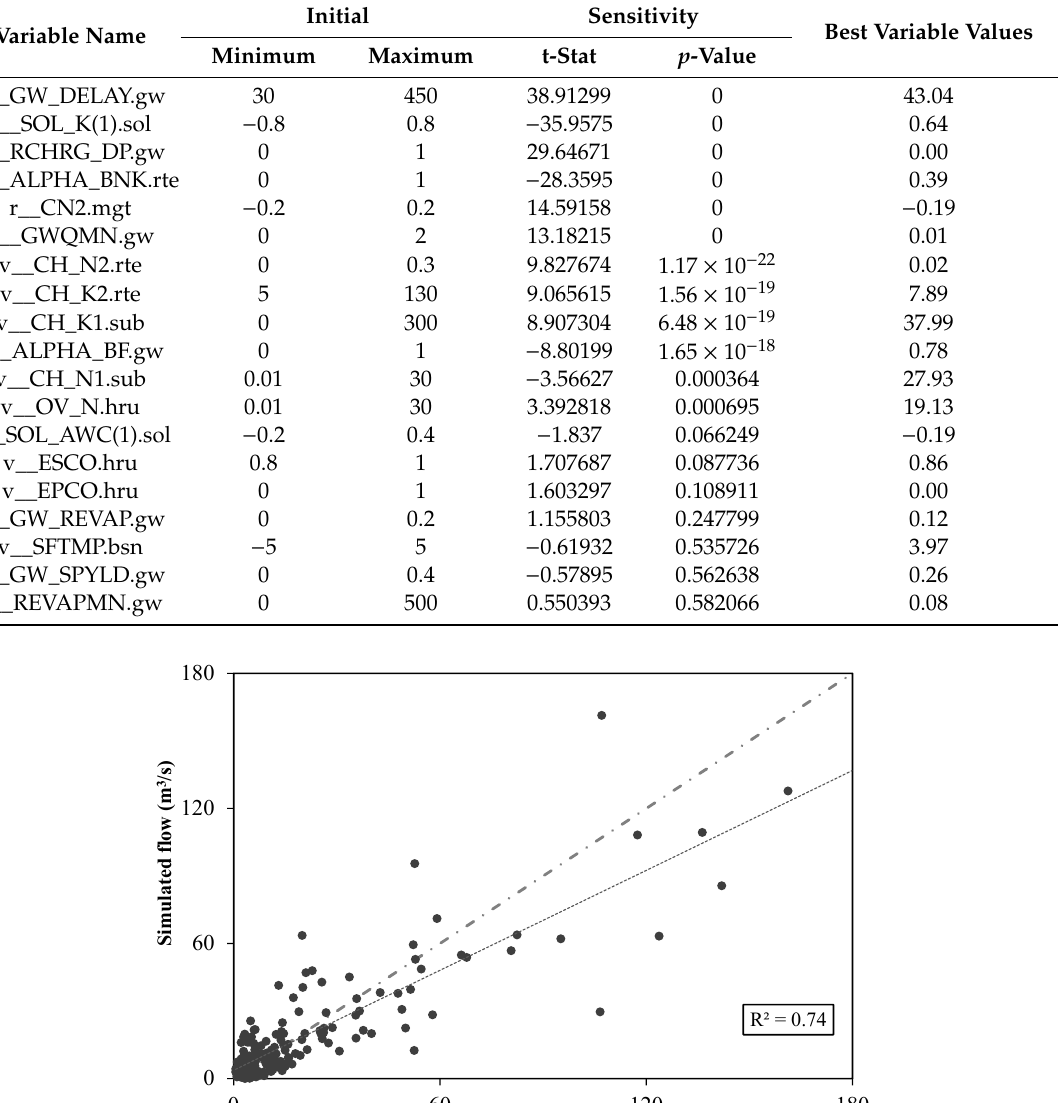
Table 2. SWAT model variables, initial and calibrated values, sensitivity results, and best model variables [84–86].